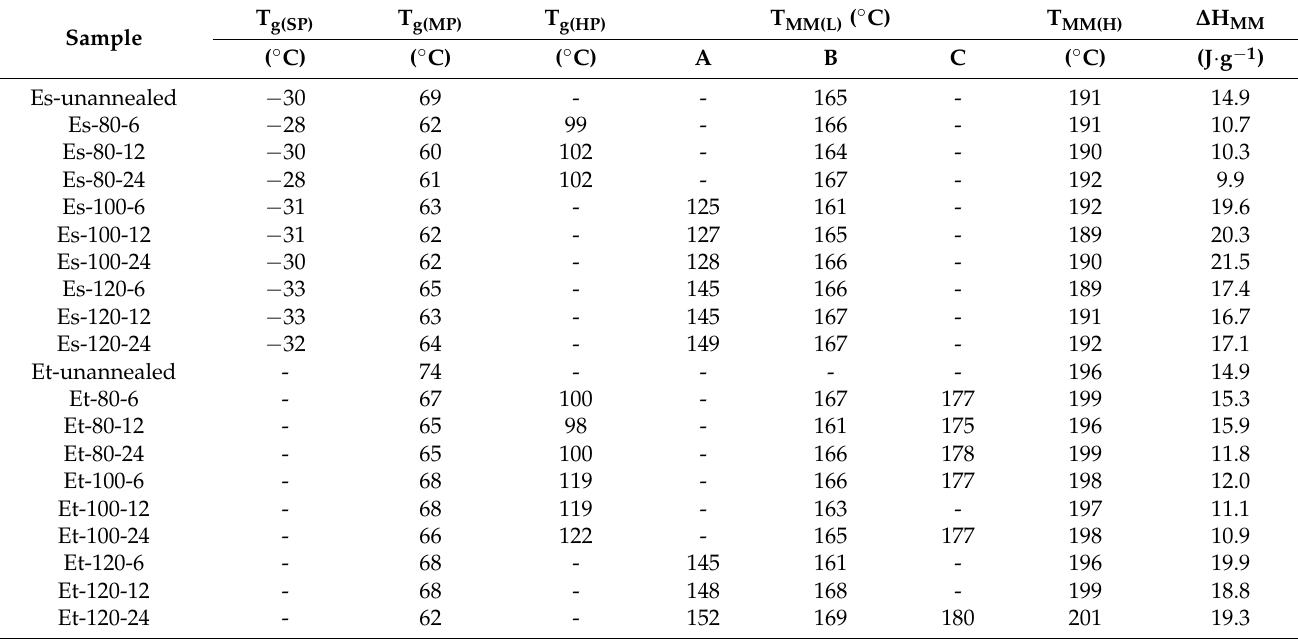
Table 1. DSC analysis of PU-Ester/MWCNT nanocomposites and PU-Ether/MWCNT